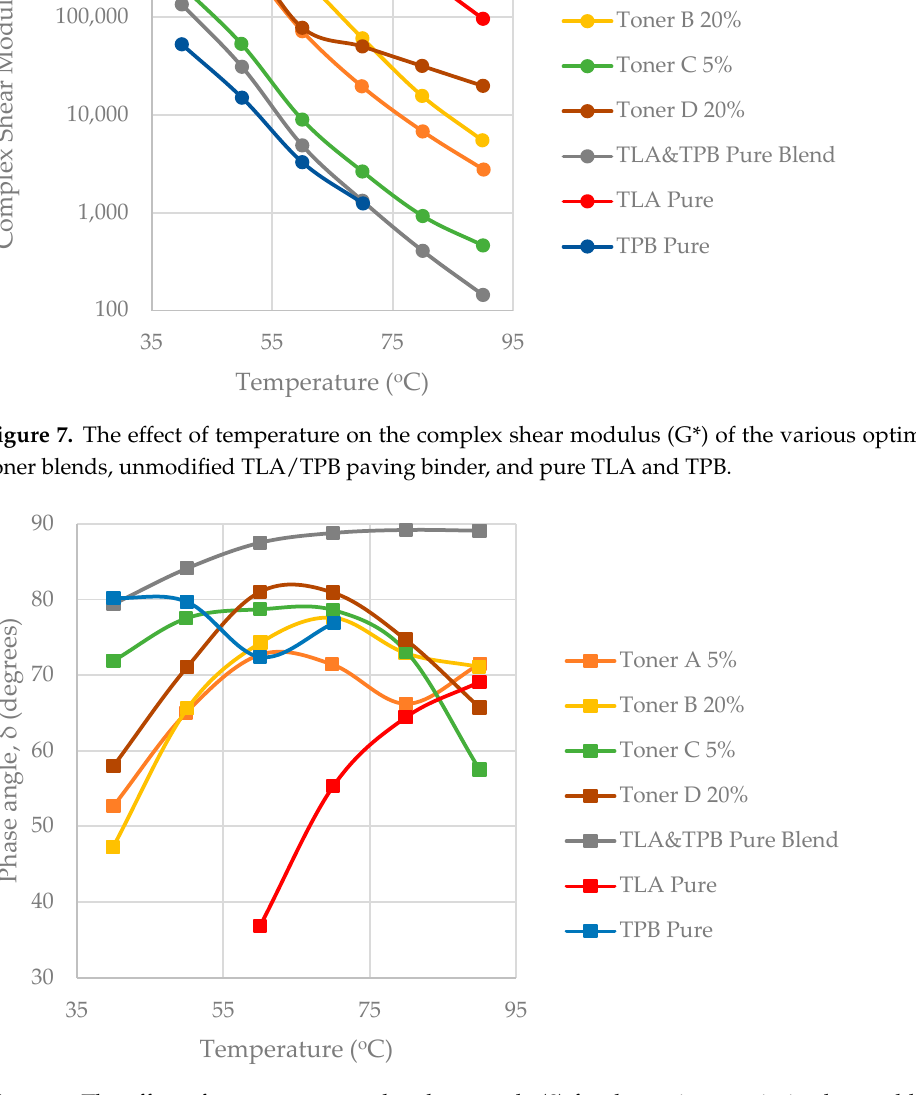
Figure 8. The effect of temperature on the phase angle ( δ ) for the various optimized toner blends, unmodified TLA/TPB paving binder, and pure TLA and TPB.